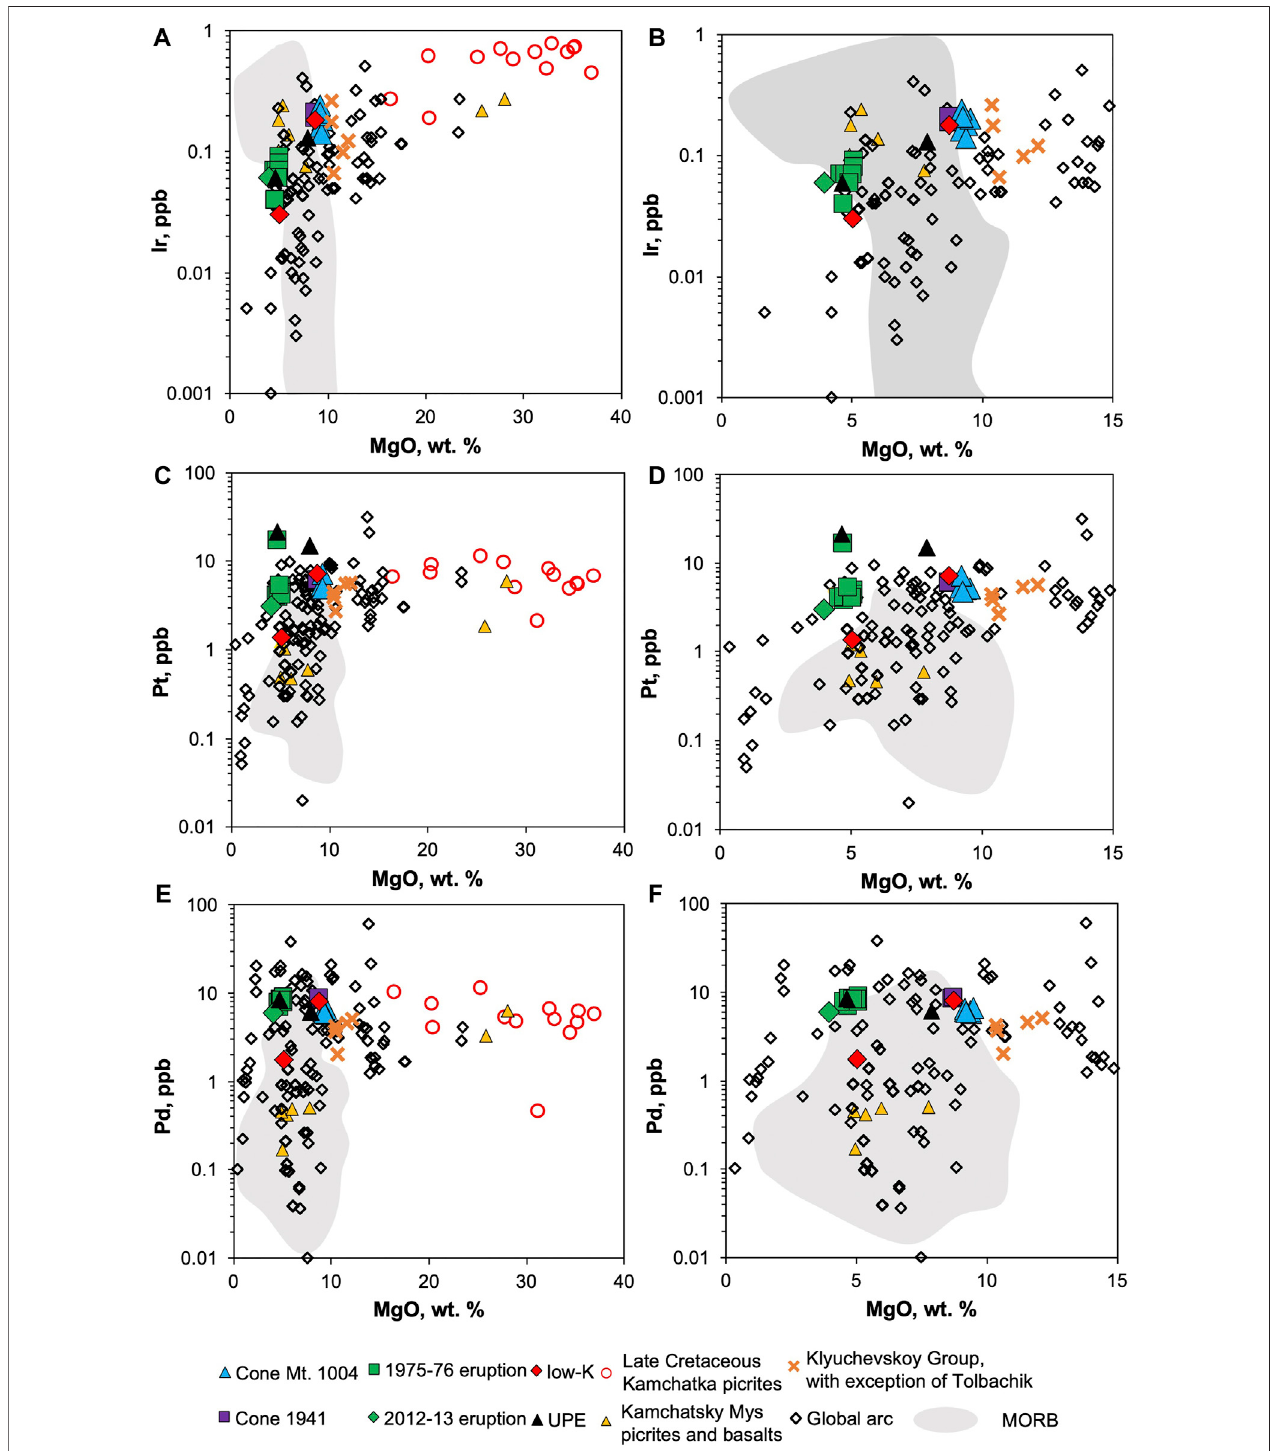
FIGURE6 | Platinum-group element variation acrossdifferentMgO contents forarc lavas and MORB. Data forthe Klyuchevskoy Group — (Nekrylov et al., 2018, in press), late Cretaceous Kamchatka picrites — (Kutyrev et al., 2021), Kamchatsky Mys (Savelyev et al., 2018a; Savelyev et al., 2018b), global arc — (Ely and Neal, 2003; Setiabudietal.,2007;Daleetal.,2008;Daleetal.,2012;Parketal.,2012),MORB — (Rehkämperetal.,1999;Peucker-Ehrenbrinketal.,2003;JennerandO ’ Neill,2012; Kelley et al., 2013; Yang et al., 2014; Reekie et al., 2019; Hao et al., 2021).